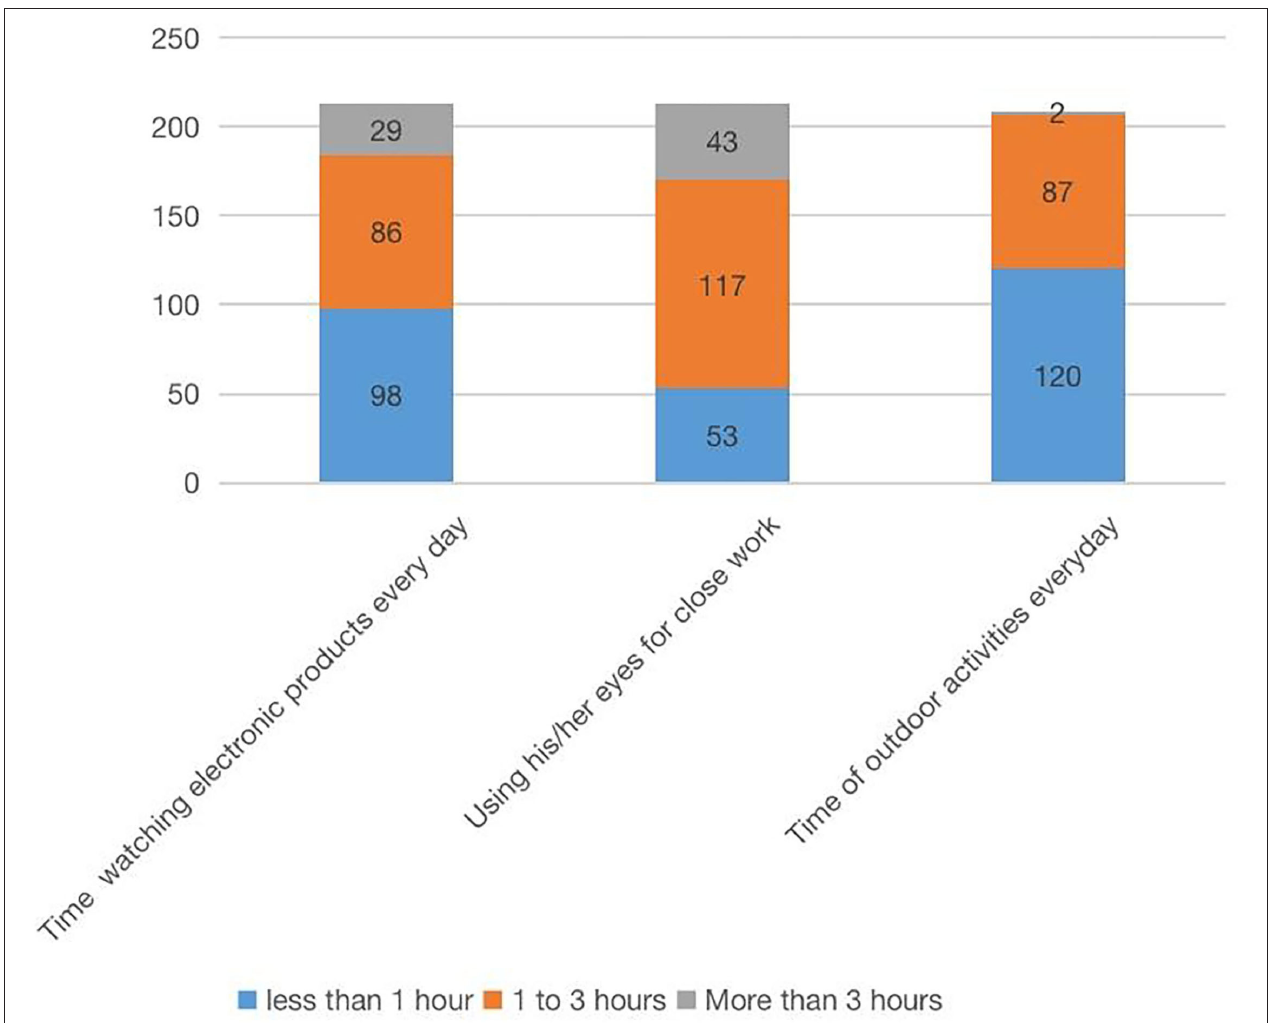
FIGURE 3 | Questionnaire content and